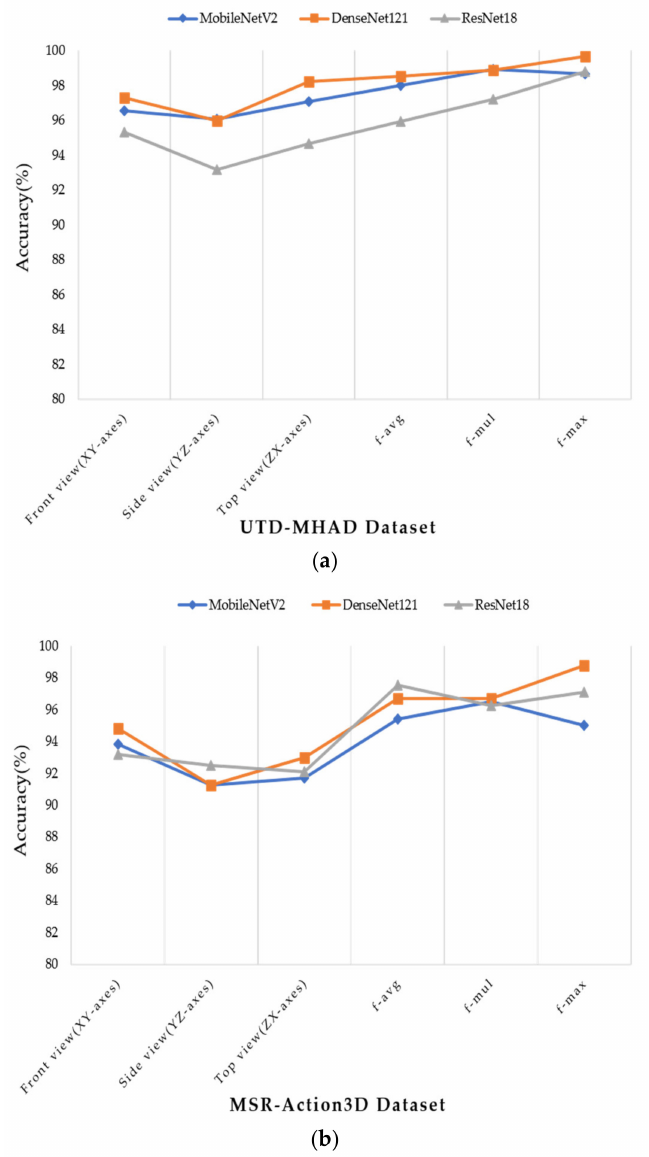
Figure 10. Visual comparisons of different views and fusions of dataset and models; ( a ) UTD-MHAD and ( b ) MSR-Action3D